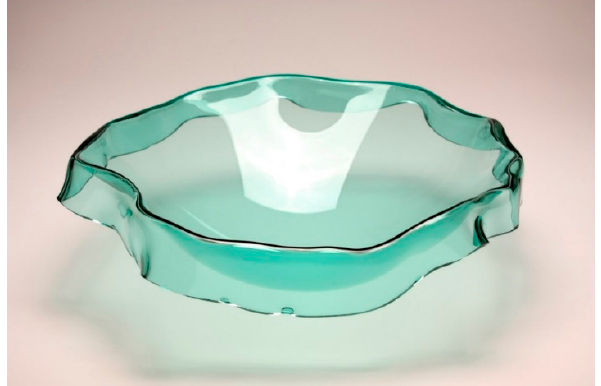
Figure 1. Large Green One-liner Bowl (2008) by Tavs Jorgensen.